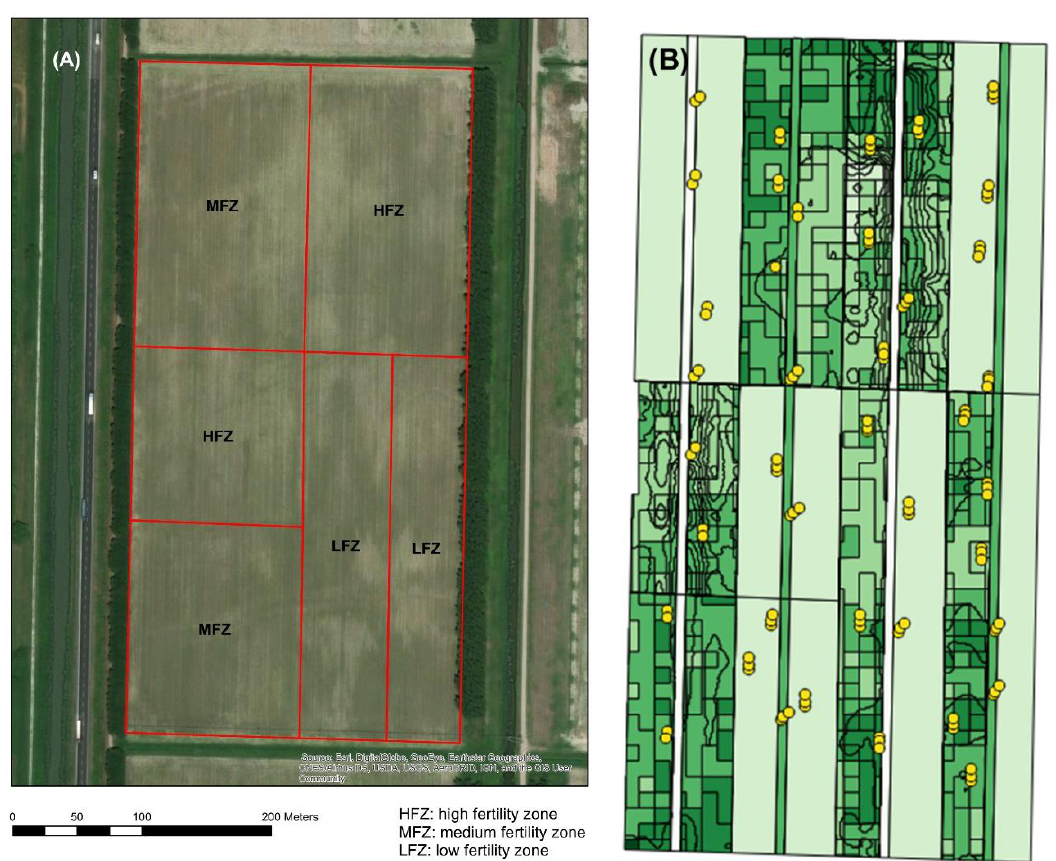
Figure 6. ( A ) Location of study site (and different fertility zones; ( B ) 120 sampling points indicated with yellow dots. HFW = high fertility zone; MFW = medium fertility zone; LMW = low fertility zone